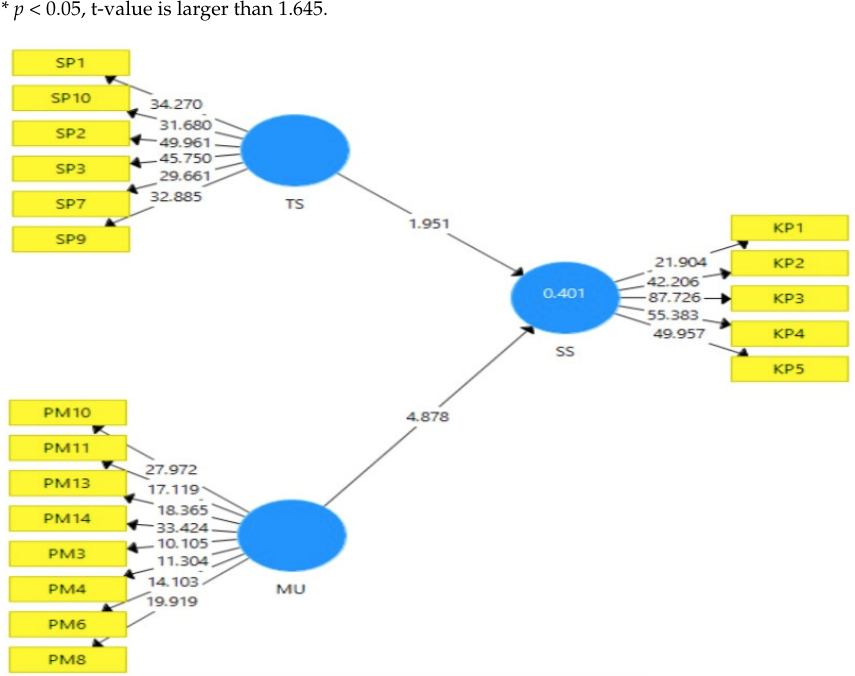
Figure 2. Structural Model. (TS: Teaching Strategies; MU: Multimedia Usage; SS: Student Satisfac- tion).